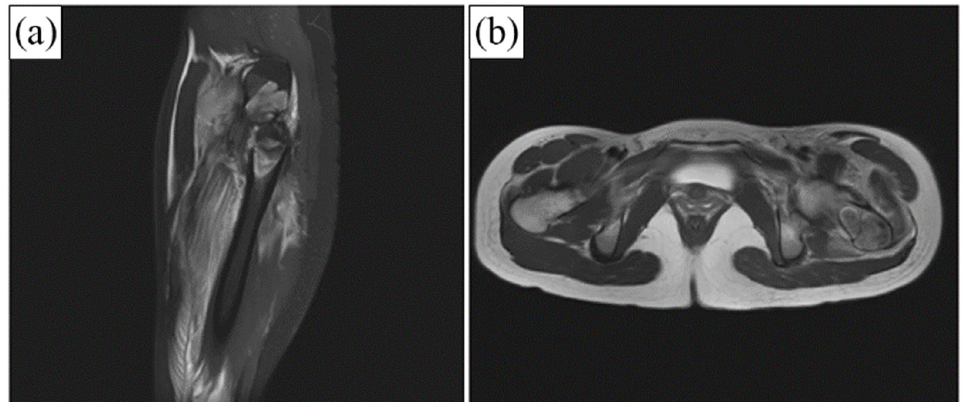
Figure 6. MRI of simple bone cyst formation in the intertrochanter region of the femur causing a compound fracture. ( a ) MRI of the fractured bone in the coronal plane. ( b ) MRI of the fractured bone in the axial plane.